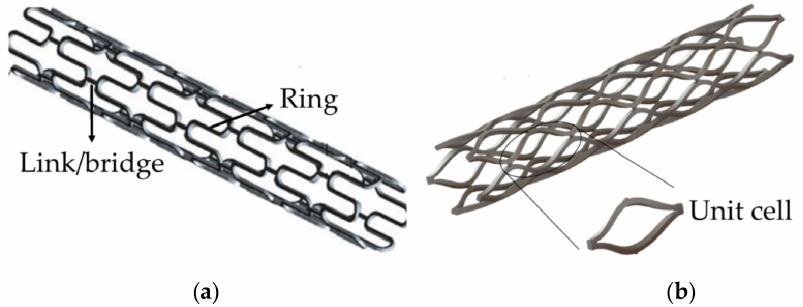
Figure 8. Two types of vascular stent designs: ( a ) Link/bridge stent [86]; ( b ) RVE/RUC stent